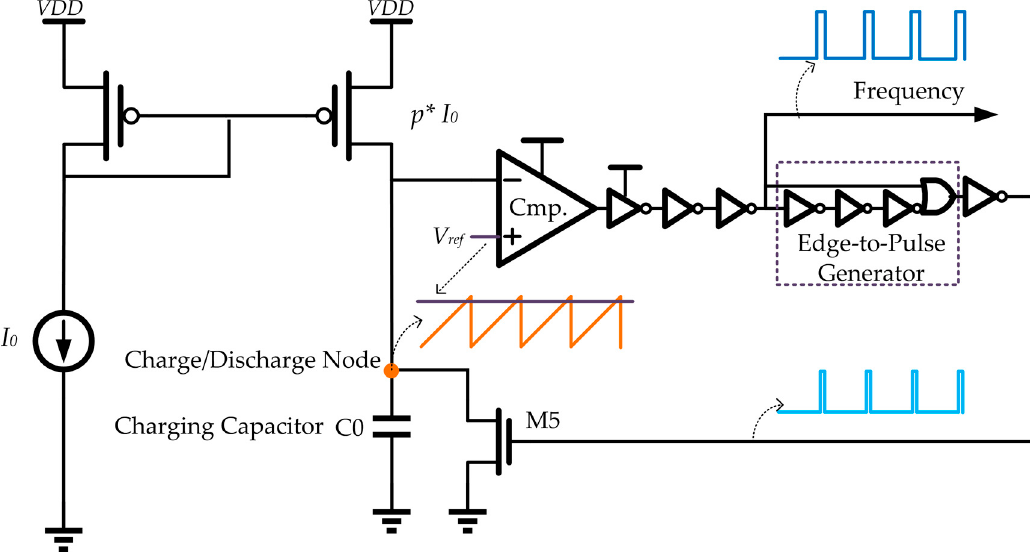
Figure 4. Circuit implementation of the current controlled oscillator.